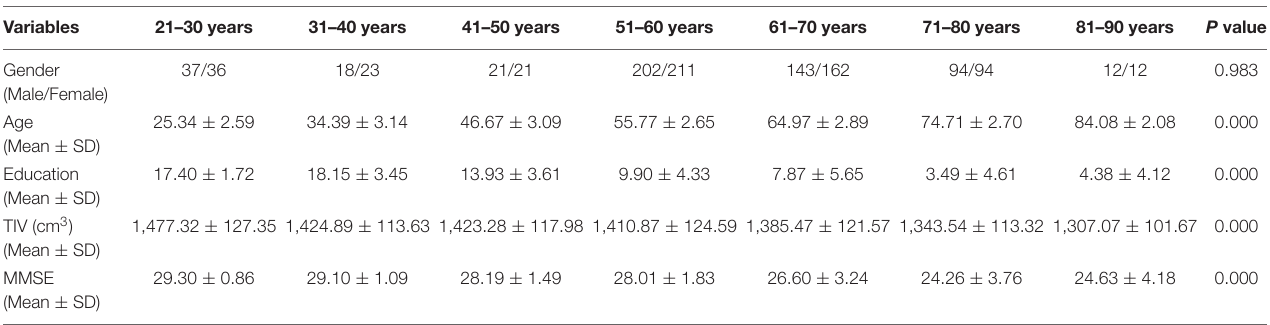
FIGURE 1 | The probabilistic connection maps of 7 CC subregions. (A) The atlas of 7 functional networks with color-coding; (B) Hard segmentation map of the highest connection probability to corresponding functional networks with the same color-coding of panel (A) ; (C) The probabilistic maps of the midsagittal CC, showing P ( v , n ) in each CC subregion. TABLE 1 | Demographic characteristics of seven age